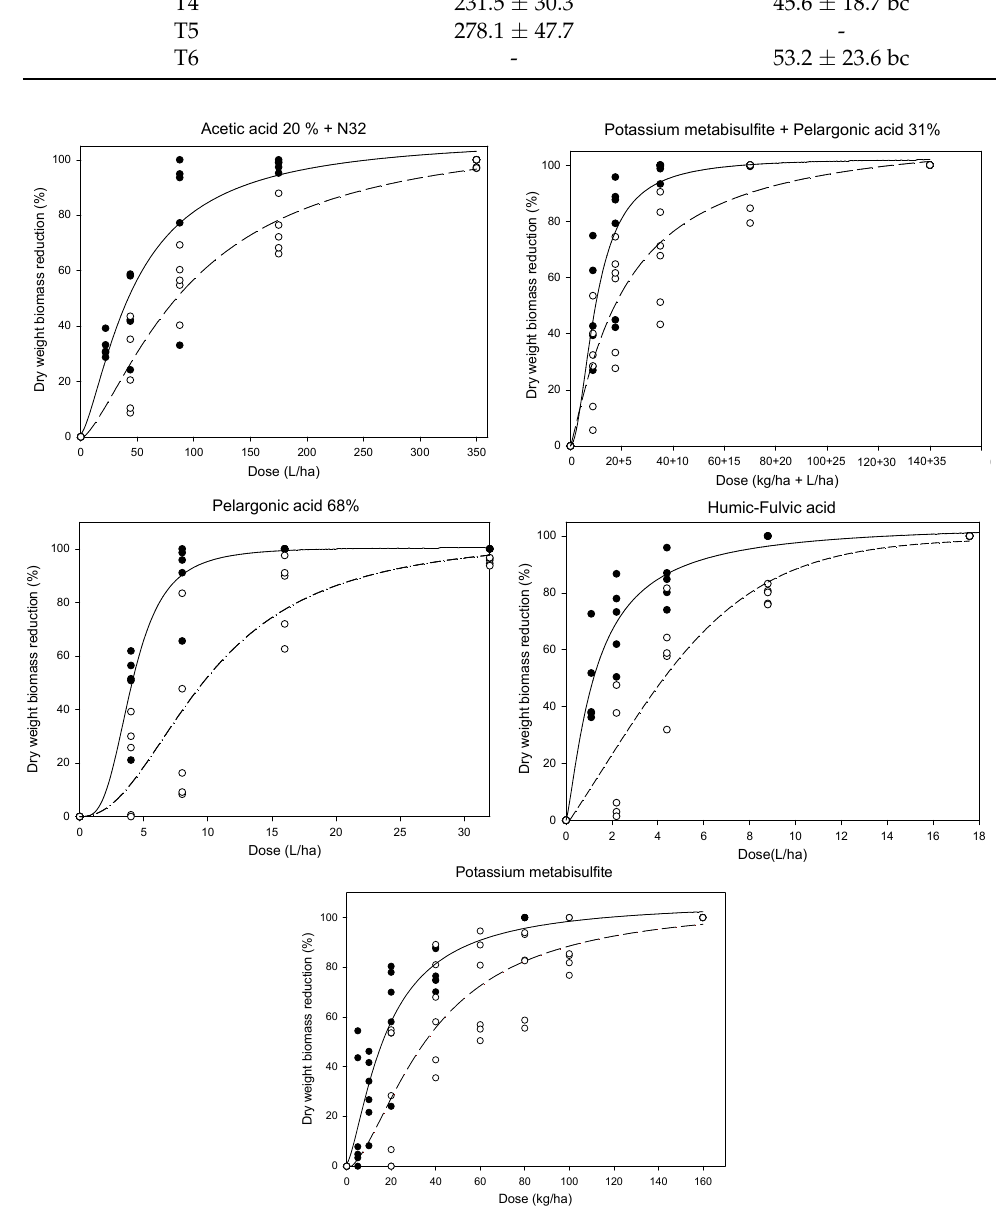
Figure 2. Dose–response curves of T1: acetic acid 20% + N32, T2: potassium metabisulfite + pelargonic acid 31%, T3: pelargonic acid 68%; T4: humic-fulvic acid, T6: potassium metabisulfite. Values are presented as dry weight biomass reduction (%) of the no-treated control. Black points ( • ) and solid lines (—), BBCH 12–13; white points ( ○ ) and dashed lines (– –), BBCH 14–15.